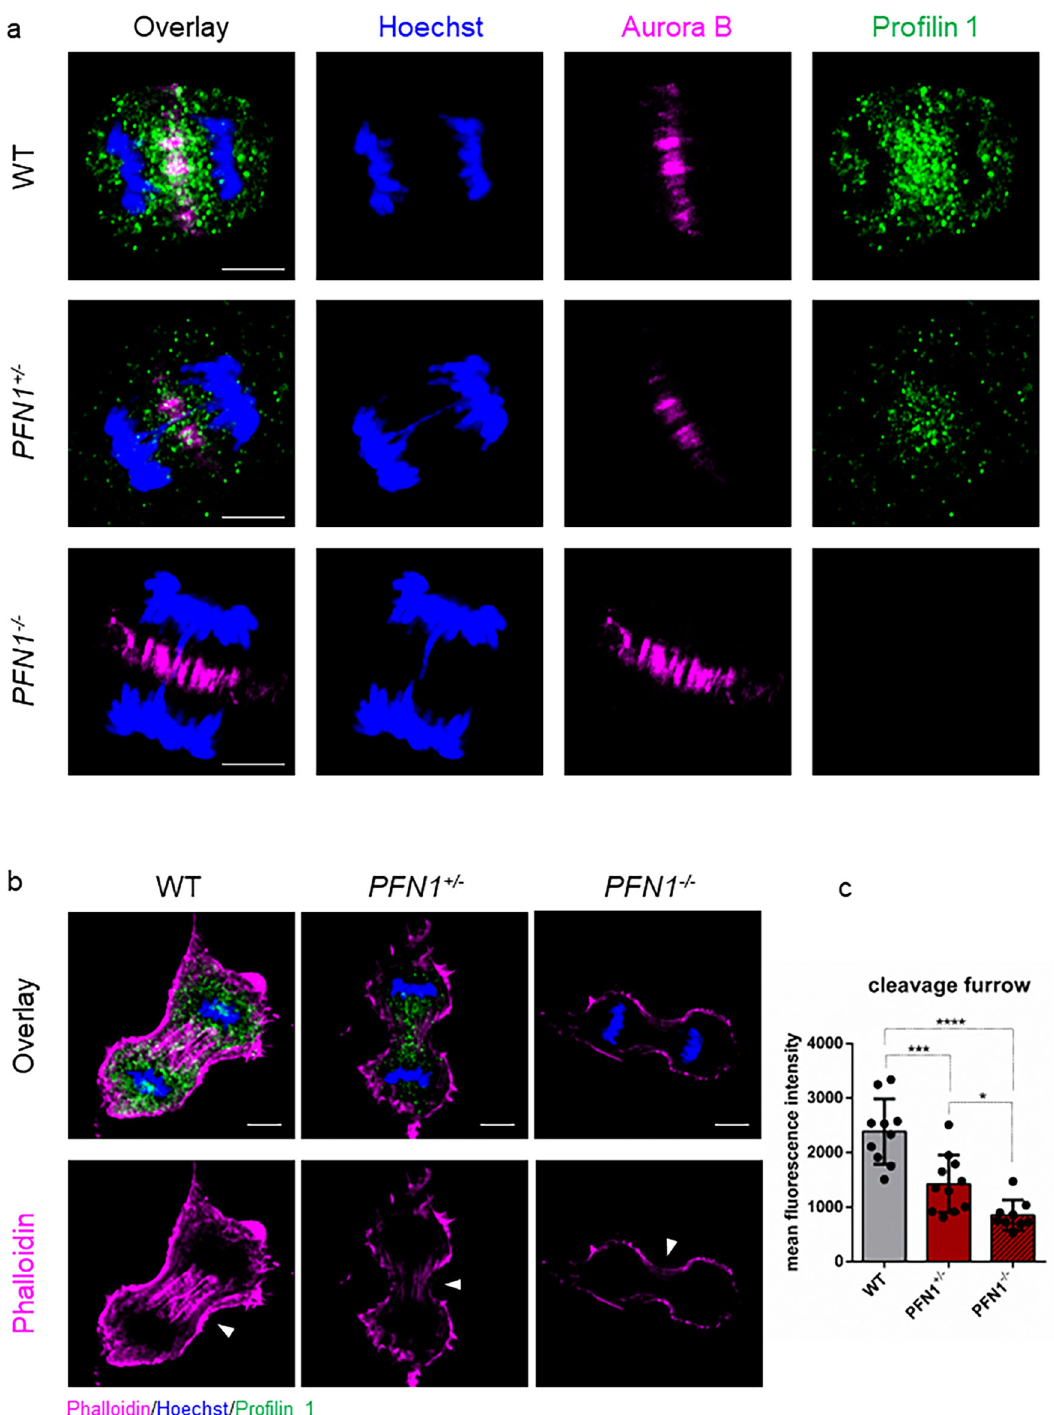
Fig. 2 Pro fi lin 1 localises in the mitotic midzone and promotes actin polymerisation at the cleavage furrow. a WT, PFN1 + / − and PFN1 − / − RPE1 cells at anaphase stained for DNA (Hoechst 33342, blue), a midzone marker (Aurora B kinase, magenta) and Pro fi lin 1 (green); scale bars 5 μ m. Note that PFN1 -KO cells show normal Aurora B localisation. b WT, PFN1 + / − and PFN1 − / − RPE1 cells at telophase stained for DNA (Hoechst 33342, blue), Pro fi lin 1 (green) and F-actin (phalloidin, magenta). Arrowheads point towards furrow ingression; scale bars 5 μ m. c Mean fl uorescence intensity of phallodin staining at the cleavage furrow; data are shown as mean ± s.e.m.; dots represent the fl uorescent intensity for each sample ( n = 10 for WT, 11 for PFN1 + / − , 9 for PFN1 − / − cells); *** P = 0.0004, **** P < 0.0001, * P = 0.0461. Ordinary one-way ANOVA mutant (PFN1 R89E ; ref. 55 ) was not associated with mitotic delay in WT cells, and did not worsen the delayed phenotype in KO cells.